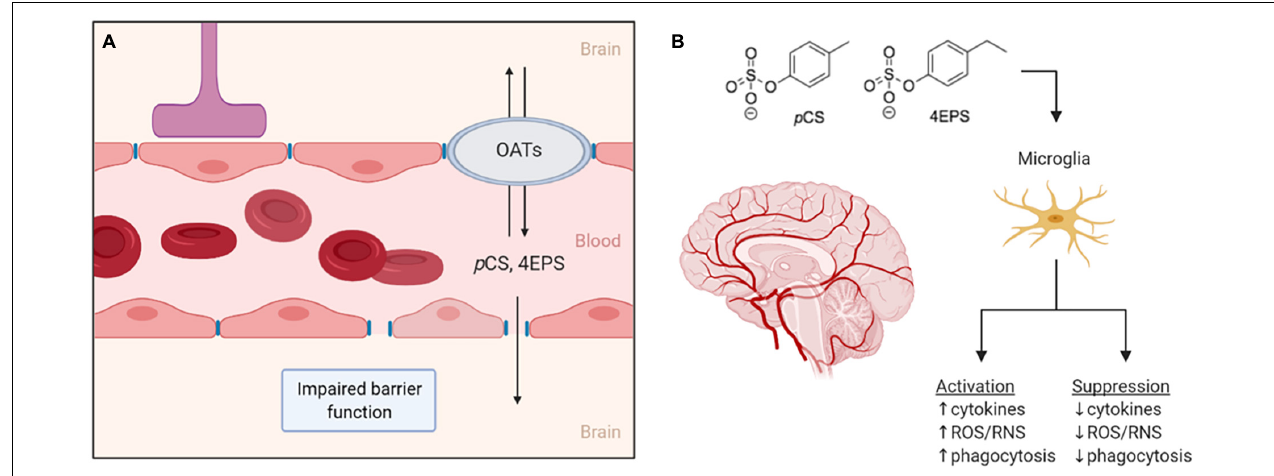
FIGURE 2 | (A) Two proposed routes for p CS and 4EPS to move from the bloodstream into the brain. The first is through the impaired blood–brain-barrier associated with ASD and the second through organic anion transporters that may be expressed in the blood–brain-barrier. (B) If p CS and 4EPS pass the blood–brain-barrier and enter the central nervous system, these bacteria-derived metabolites might affect microglial cells, either by activating or suppressing them. OATs, organic anion transporters; p CS, p -cresyl sulfate; 4EPS, 4-ethylphenyl sulfate; ROS/RNS, reactive oxygen/nitrogen species. Created by